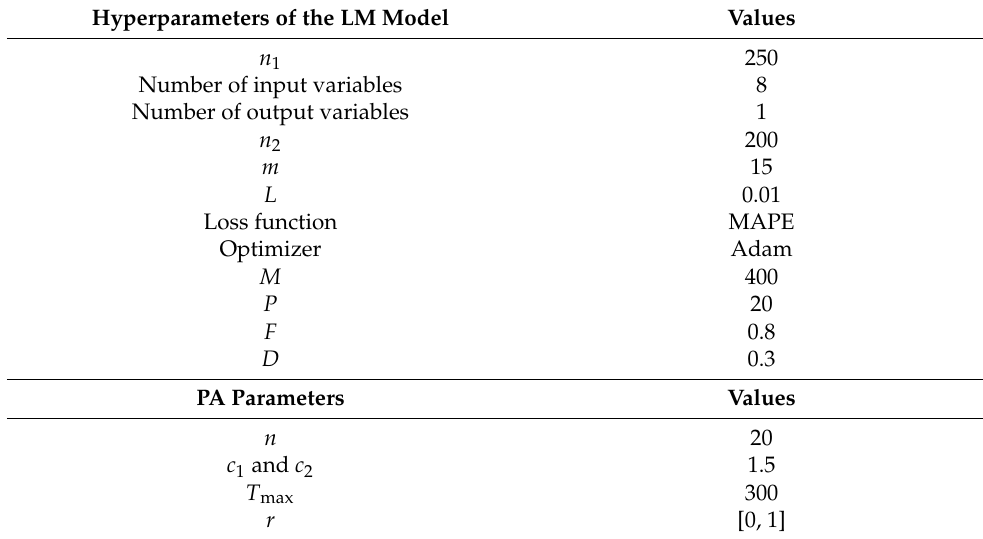
Table 3. The key parameters used in the PA-LM model. Hyperparameters of the LM